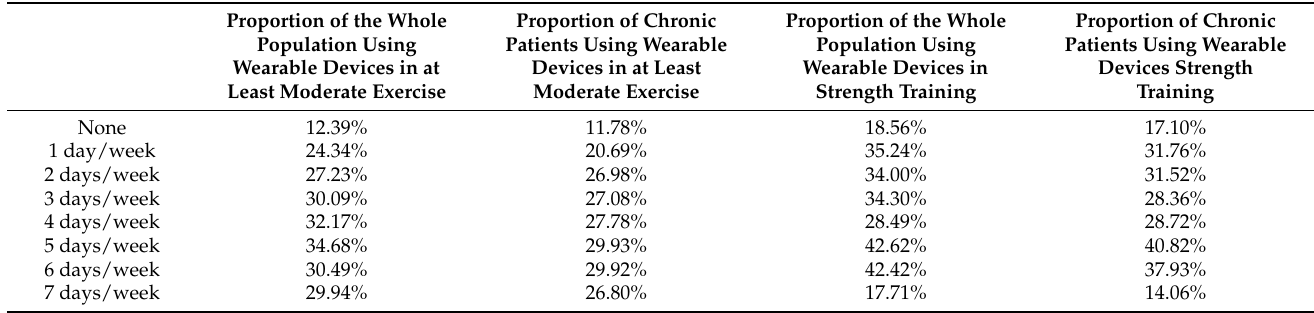
Table 1. Proportion of people using wearable devices in each exercise group.